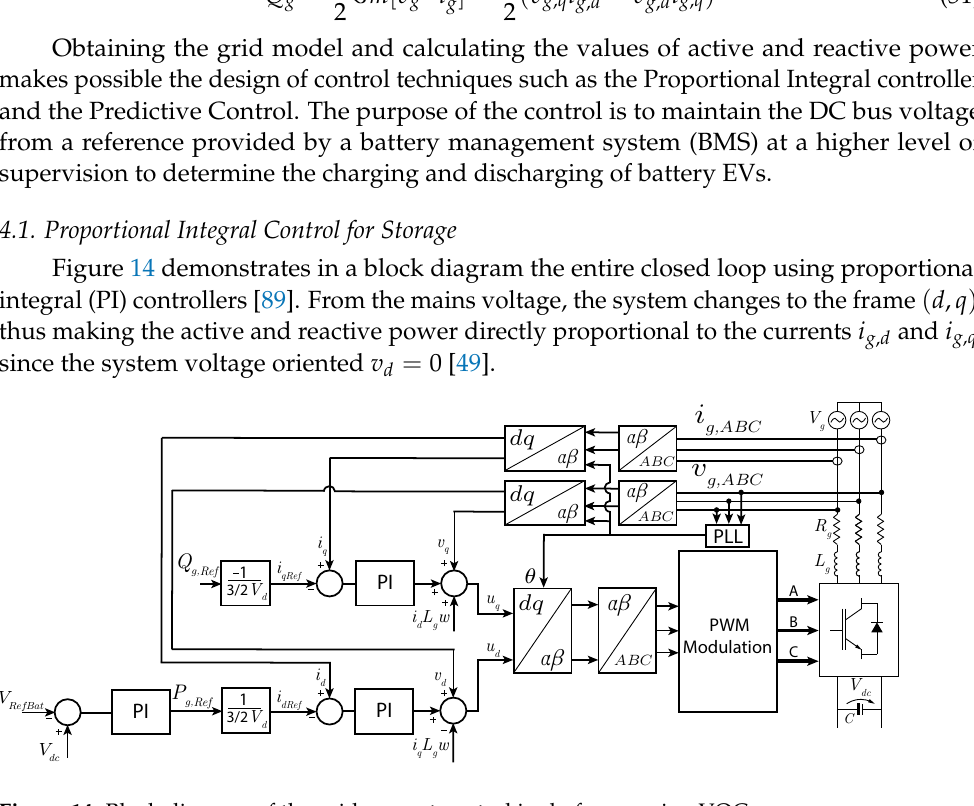
Figure 14. Block diagram of the grid current control in dq frame using